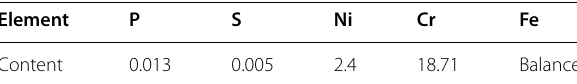
Table 3 Chemical composition of iron-based alloy powder (mass fraction, %) Element